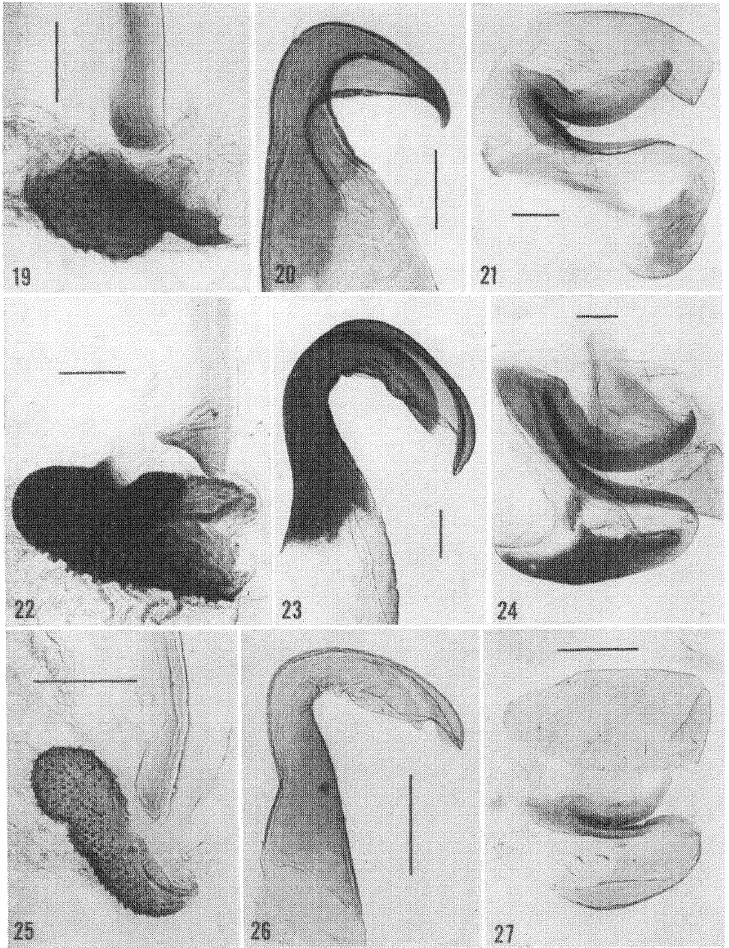
Figures 19-27. Male genital phallomeres of PerisIhaeria and Cyrtotria spp. 19-21. (1419 L). P. saxicola (from shown in Fig. 5). 22-24. (1422 L). P. ruficornis (from shown in Fig. 6). 25-27. (15 HO). Cyrtotria sp. (from shown in Fig. 105). (scale--=-0.2